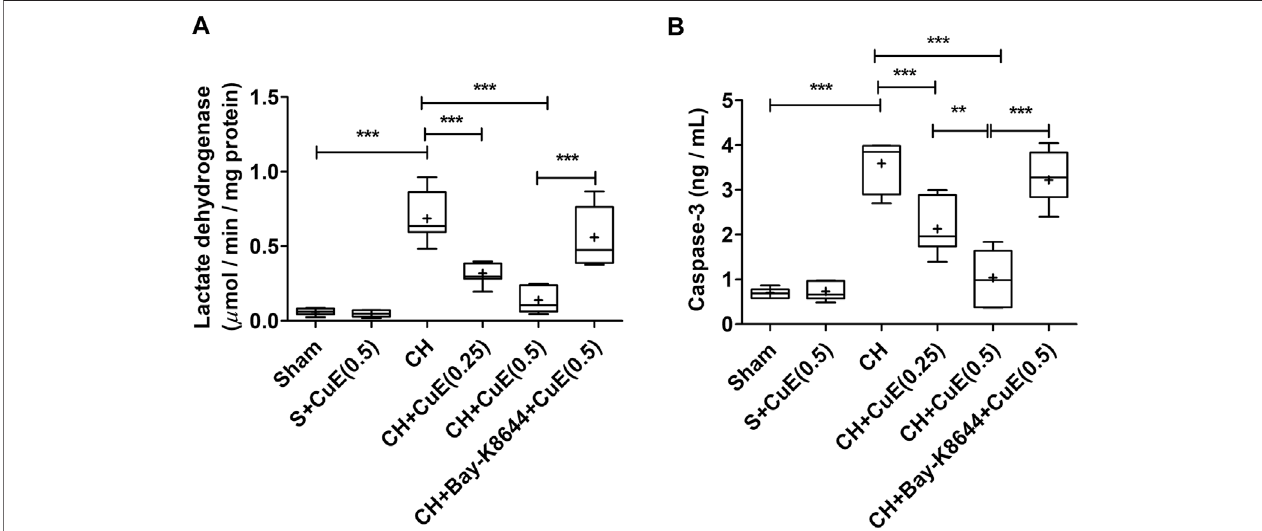
FIGURE 5 | CuE post-treatment (0.25 and 0.5 mg/kg, p.o. ) for 28 days attenuated cell death against CH. CuE signi fi cantly lowered (A) LDH activity and (B) caspase-3 levels in the brain of rats exposed to CH on day 1. Bay-K8644 attenuated pro-survival effects of CuE. Box and whisker plots (Tukey) show mean (+), median (bold horizontal line), quartiles (box), and total range (whisker) ( n (cid:1) 7). * ( p < .05), ** ( p < .01), *** ( p <